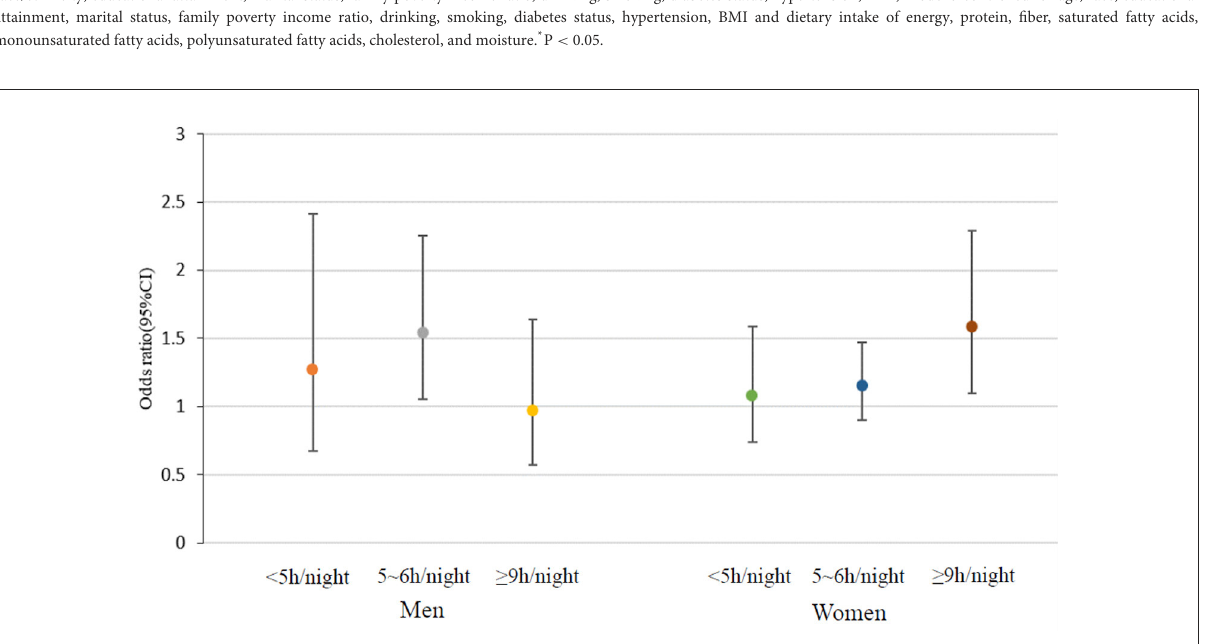
FIGURE2 Association of sleep duration with constipation in men and